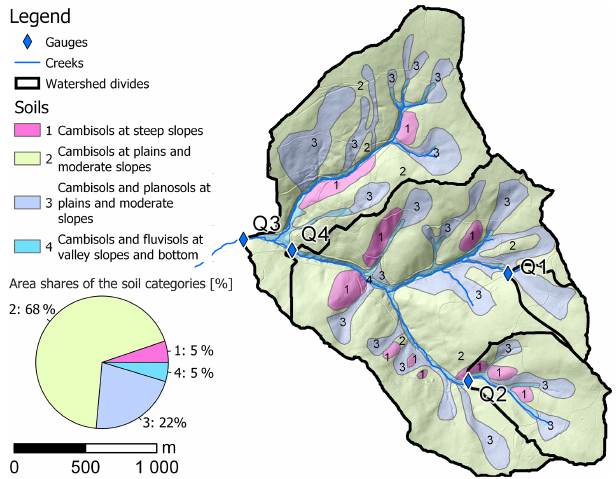
Figure 3. Soil map with the four main soil categories, watershed divides and discharge